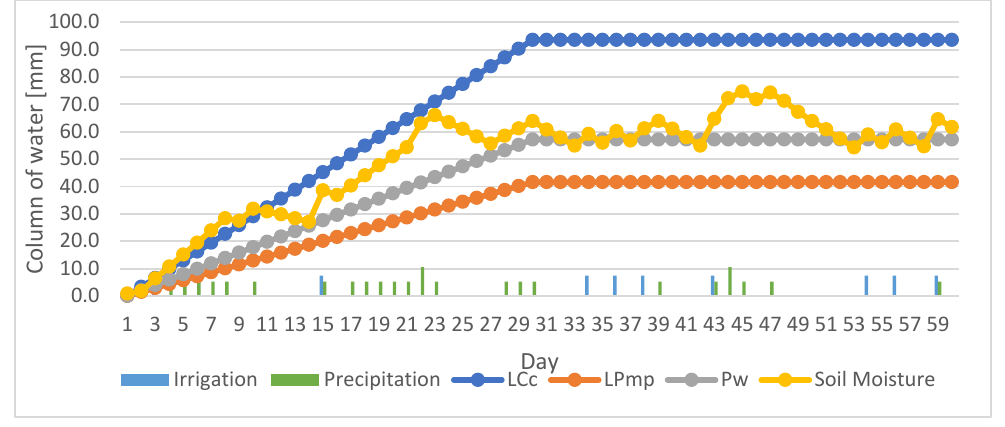
Figure 6. Proposed smart